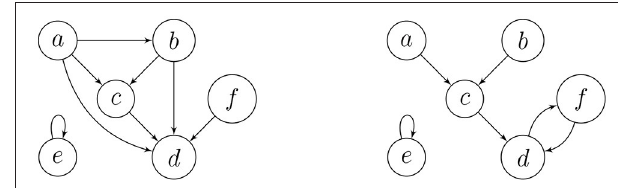
FIGURE 1 | Digraphs for a transitive relation and a